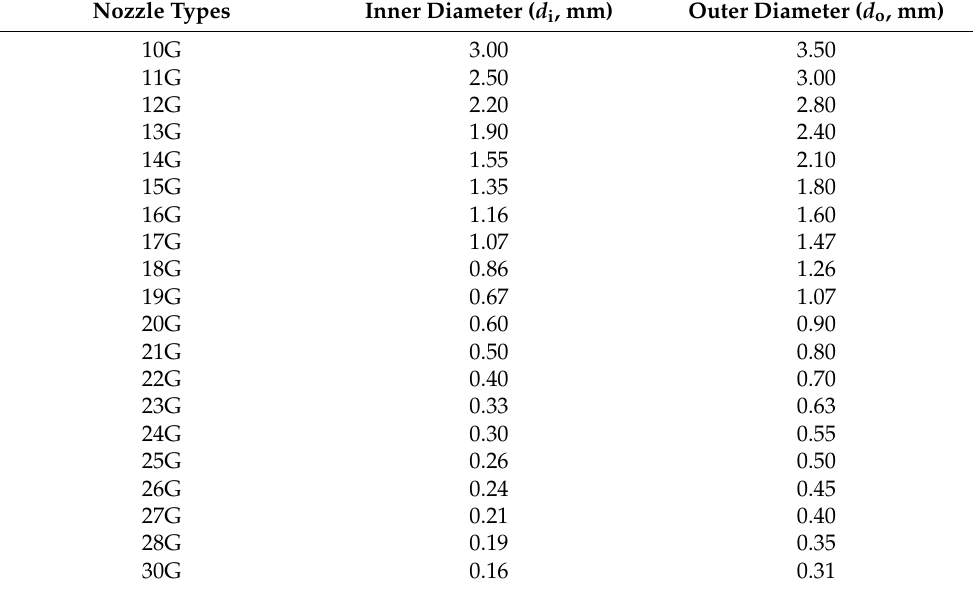
Table 2. Dimensions of atomization